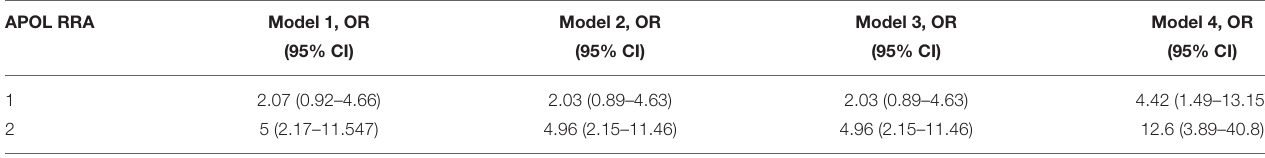
TABLE 4 | Odds ratio (OR) and 95% confidence intervals (CIs) for the association between APOL1 risk genotype and CKD. APOL RRA Model 1, OR Model 2, OR